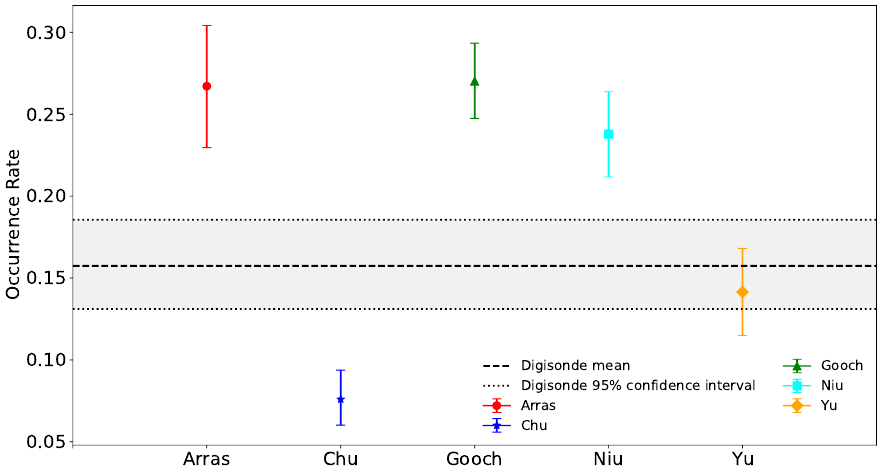
Figure 4. Bootstrap calculated means and 95% confidence intervals for each GPS-RO technique compared to the ionosonde rates over all seasons and years for no lower limit on E s intensity. Each point represents the mean and confidence interval for the GPS-RO technique displayed below on the abscissa, while the dashed line and shaded region across all techniques shows the Digisonde mean and 95% confidence